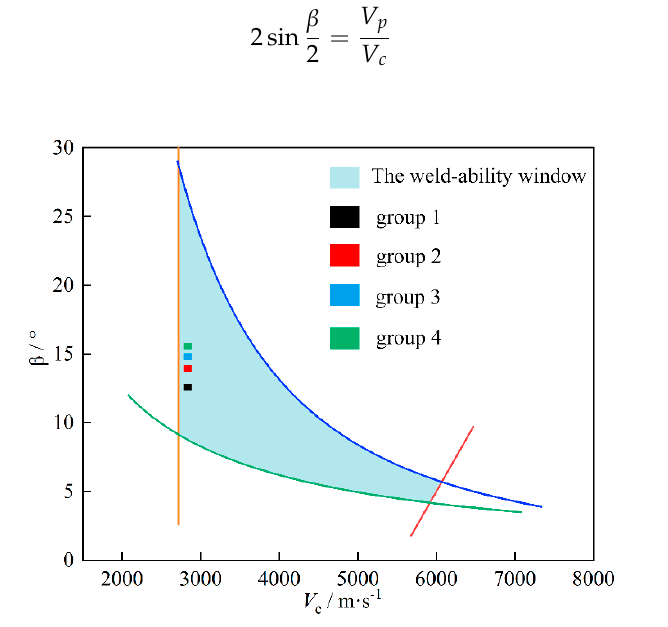
Table 1. Initial parameters used for explosive welding.